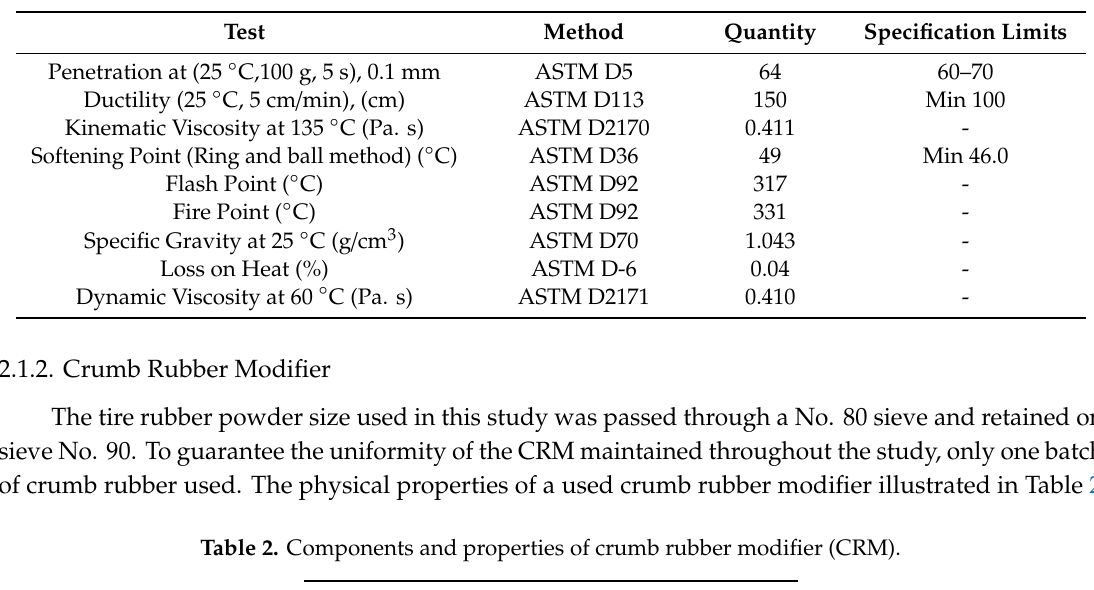
Table 1. Physical properties of the base asphalt.